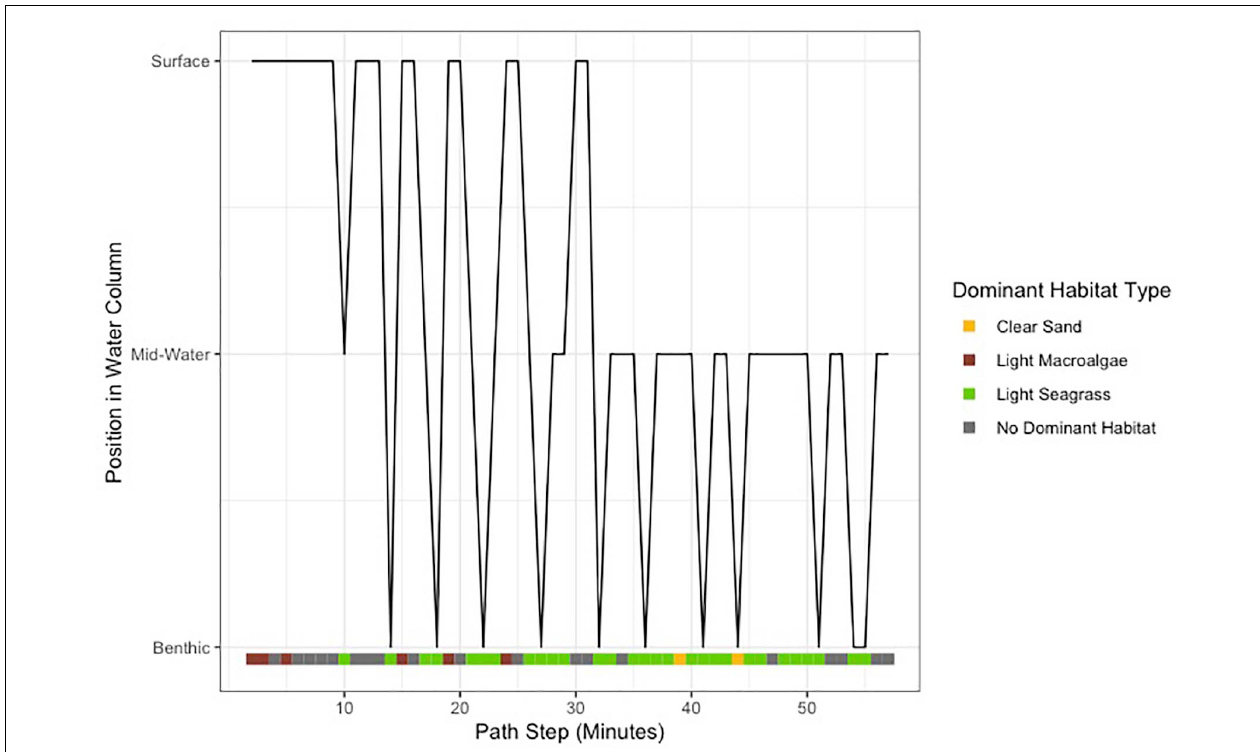
FIGURE 3 | Qualitative estimates of shark depth over the track, with dominant habitat type represented by color